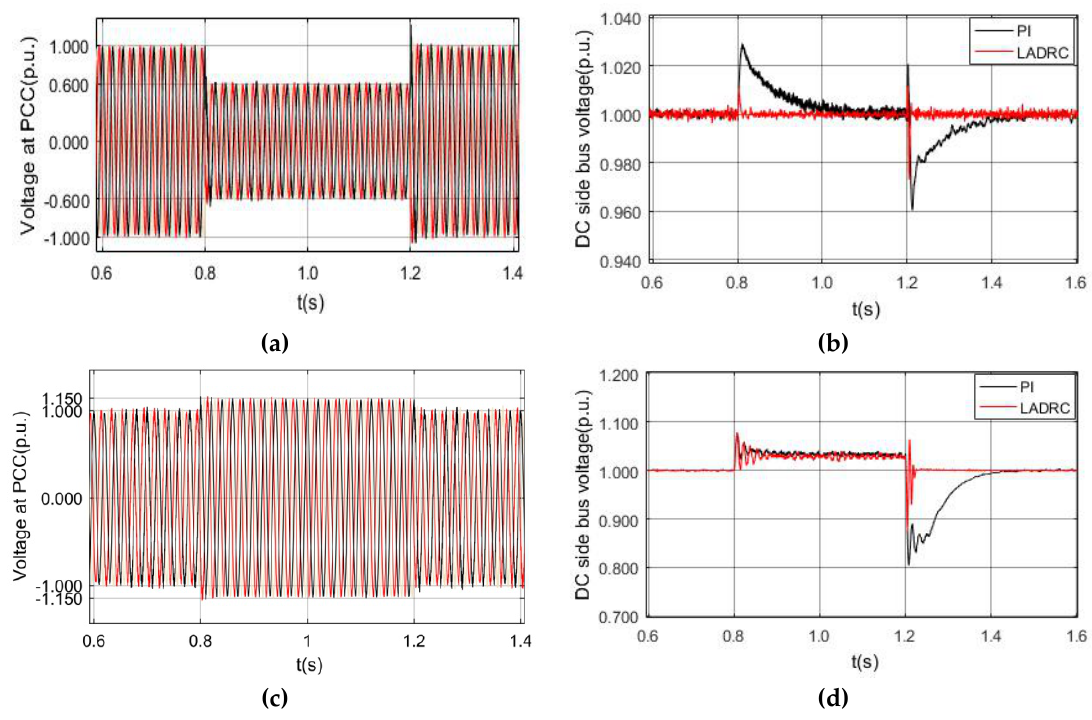
Figure 11. Dynamic response curve of direct current (DC) bus voltage when proportional integral (PI) control and LADRC are used in voltage outer loop ( a ) grid-side voltage drops to 60% ( b ) Voltage waveform of DC side bus when voltage drops to 60% ( c ) grid-side voltage rises to 115% ( d ) Voltage waveform of DC side bus when voltage rises to 115%.